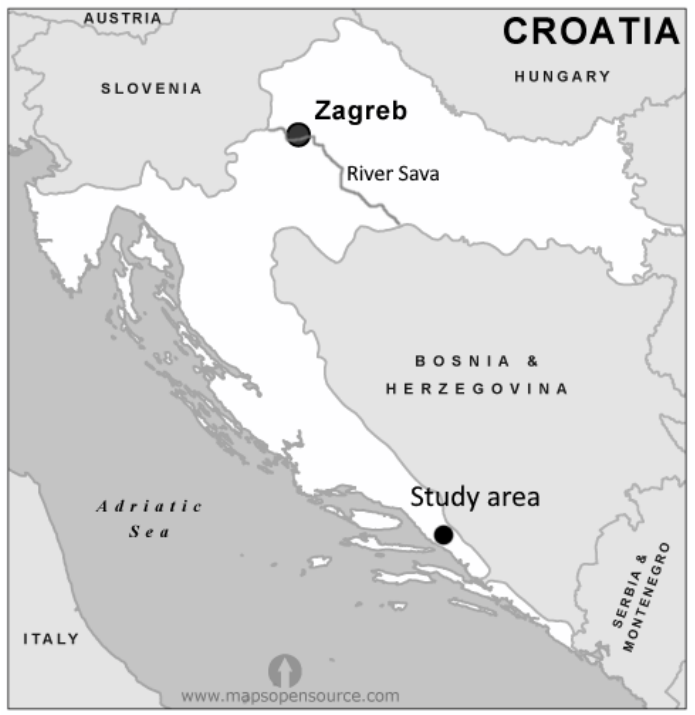
Figure 1. Study area in Croatia, Dalmatian hinterland region.